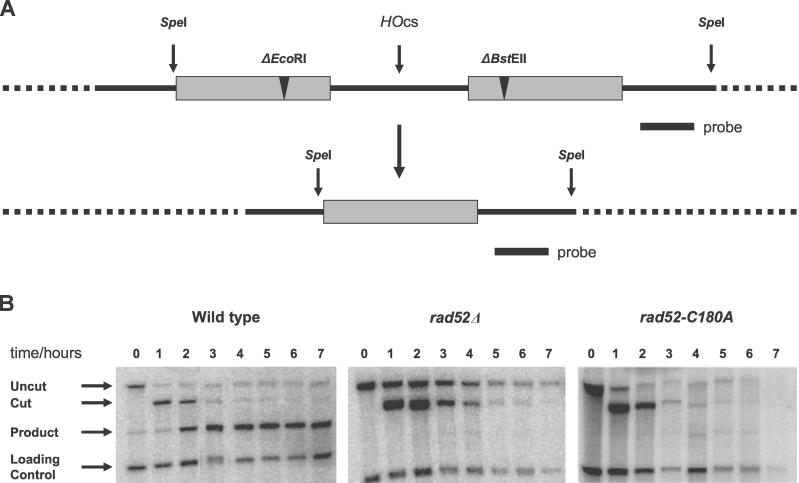
Kinetics of the Repair of a DSB Produced between Directly Repeated leu2 Heteroalleles(A) Graphical representation of the assay used to follow HO-endonuclease-induced direct-repeat HR. The positions of the leu2-ΔBstEII and leu2-ΔEcoRI heteroalleles are indicated by black wedges. The position of the HO cut-site, HOcs, is indicated by an arrow. The product resulting from DSB repair by SSA is shown below the direct-repeat assay. Note that the product is given as a wild-type sequence, but it could also contain any combination of the leu2-ΔBstEII and leu2-ΔEcoRI alleles, as the analysis performed here does not discriminate between these possibilities. Arrows labeled SpeI indicate the positions of the SpeI cut-sites used to release the region from its chromosomal context for genomic blot analysis. Horizontal bars represent the location of the probe used for genomic blot analysis.(B) The DSB was produced by induction of the HO-endonuclease and repair was analyzed in three different strain backgrounds, wild-type, rad52Δ, and rad52-C180A, as indicated. In each strain, the kinetics of three DNA species in the process was followed: uncut DNA, cut DNA, and product. The positions of these species are indicated by arrows. A DNA fragment serving as loading control (see Materials and Methods) is also visualized. The number above each lane indicates the time point after induction of the HO-endonuclease in hours.